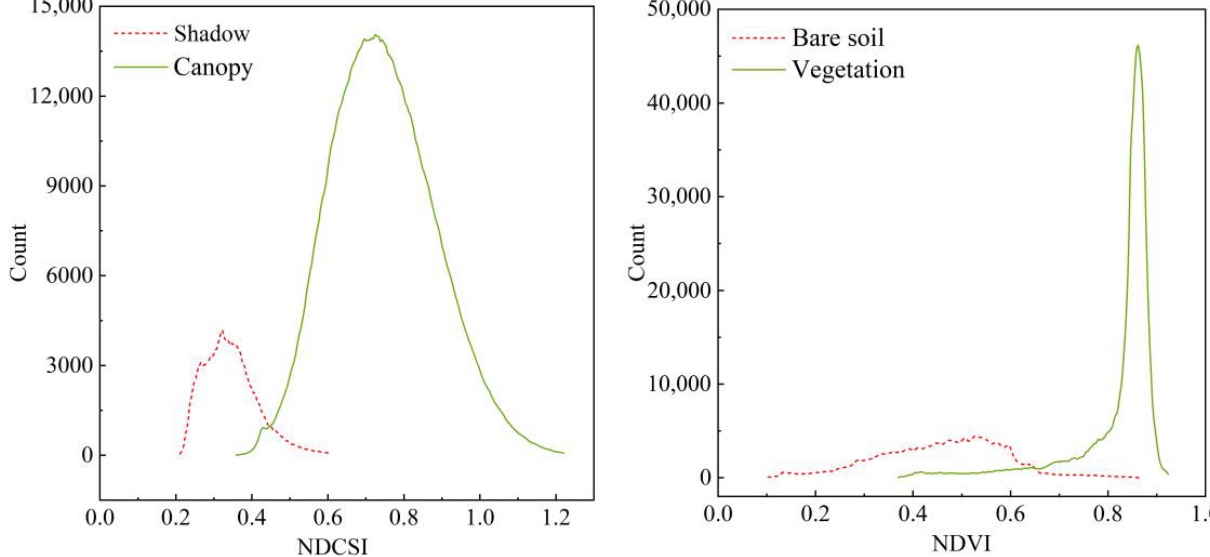
Figure 3. Extraction of VIs threshold. Lines indicate the number of pixels for canopy, bare soil, and shadow in the quadrat, respectively.